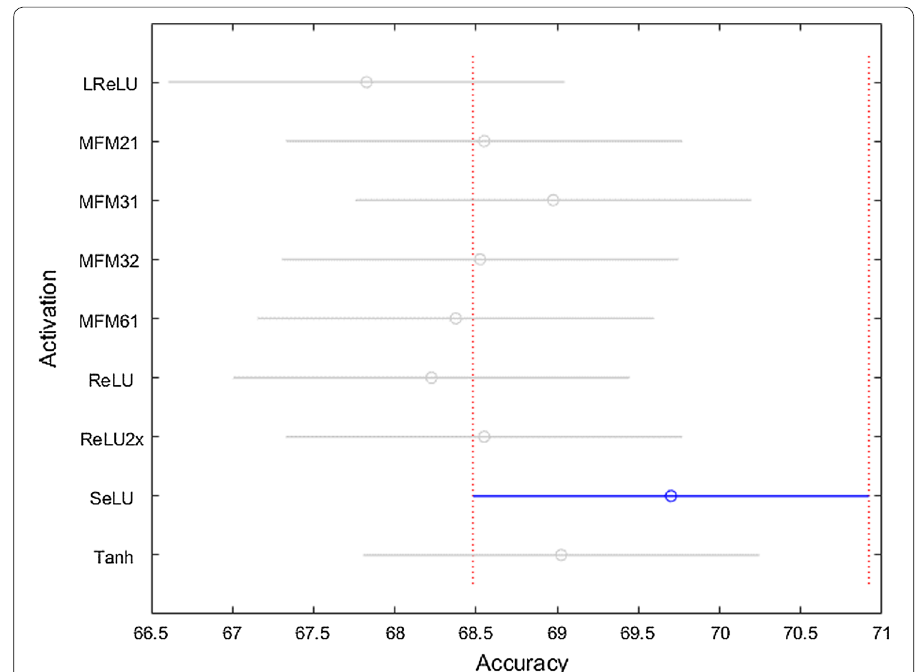
Fig. 13 Multiple comparisons, activations on medical datasets